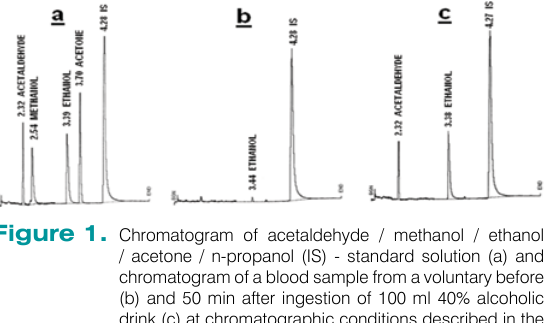
Figure 1. Chromatogram of acetaldehyde / methanol / ethanol / acetone / n-propanol (IS) - standard solution (a) and chromatogram of a blood sample from a voluntary before (b) and 50 min after ingestion of 100 ml 40% alcoholic drink (c) at chromatographic conditions described in the text.